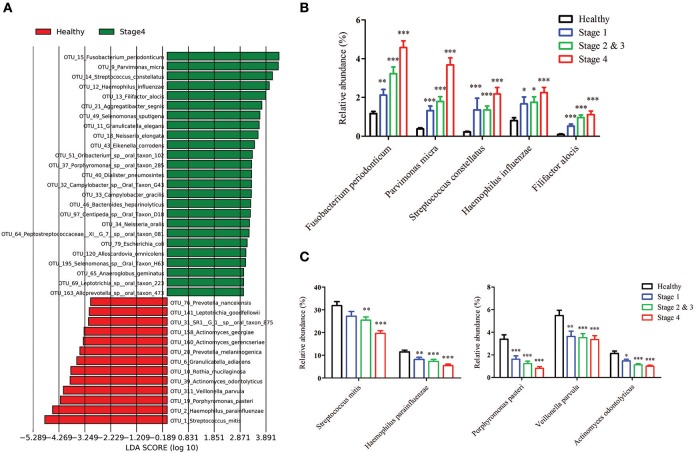
The differentially enriched bacteria in OSCC patients when compared to healthy controls. (A) Linear discriminant analysis effect size (LEfSe) analysis showing bacteria at the species level that were altered between the OSCC stage 4 and healthy controls. The relative abundance of the upregulated bacteria (B) and downregulated bacteria (C) at the species level in OSCC.